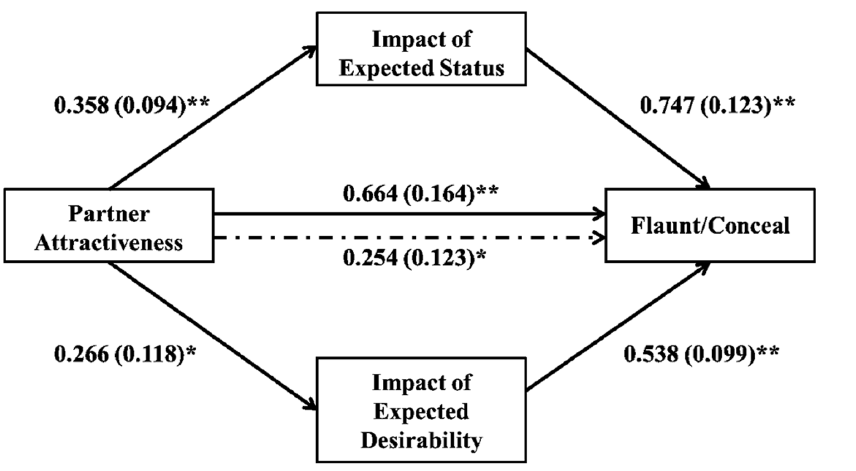
Figure 3. Mediation model showing the relation between partner status and flaunting/concealing as mediated by the expected impact on status and desirability. Note. Unstandardized coefficients illustrated with standard errors in parentheses. One asterisk indicates (p , .05); two asterisks indicate (p , .01). Solid line from IV to DV shows the total effect of the IV on the DV (c path); the dashed line shows the direct effect of the IV on the DV (c-prime